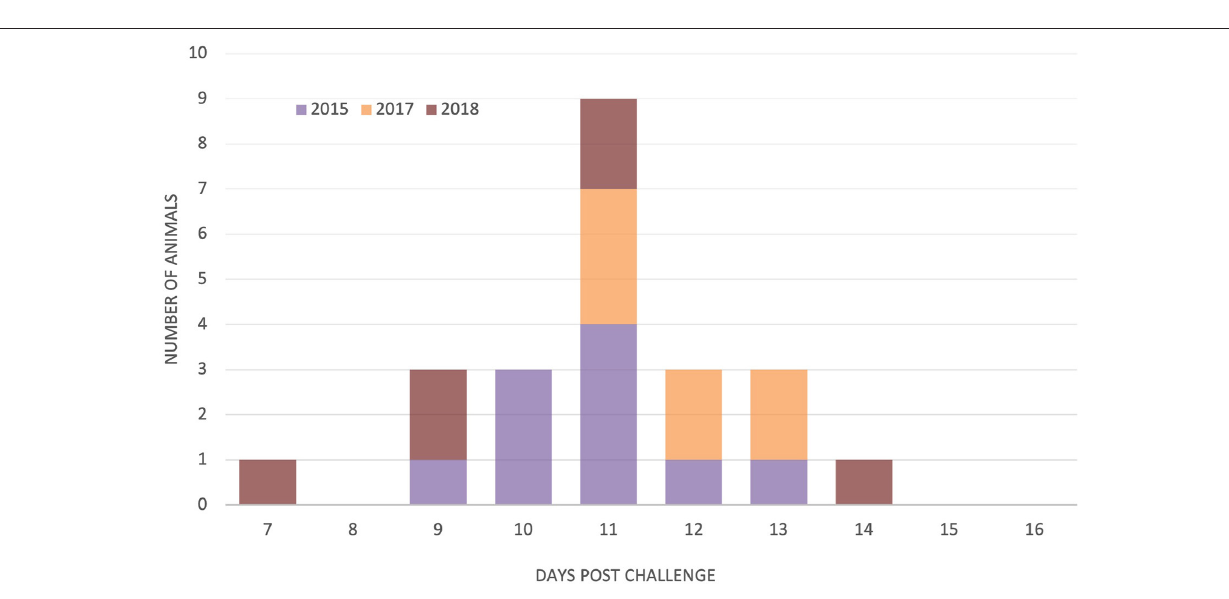
acini were observed in six ticks, and these and a further two ticks were shown to be positive by both p67 and 18S RNA gene amplification by PCR; an overall infection rate was